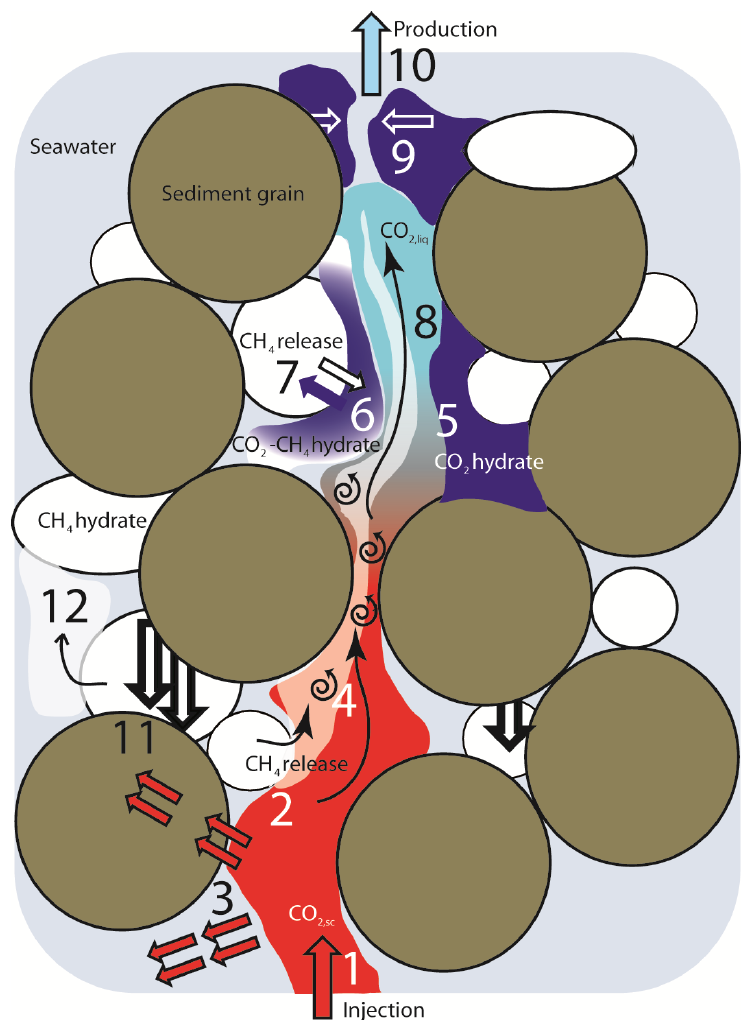
Figure 9. Process dynamics scheme. Relevant transport and reaction processes during injection of hot CO into CH -hydrate bearing sediment. (1) Injection of hot, mobile 2,sc 4 CO ; (2) Fast dissociation of CH -hydrate due to thermal stimulation from hot CO 2,sc 4 2,sc injection; (3) Conductive heat transport via sediment particles or non-mobile pore water followed by thermal stimulation and dissociation of distant CH -hydrate particles; 4 (4) Mixing of CO and CH ; (5) CO -hydrate formation with pore water; (6) Formation of 2 4 2 mixed CO -CH -hydrates from CO -CH gas mixtures; (7) CH -CO -hydrate exchange 2 4 2 4 4 2 limited by diffusive transport of CH and CO ; (8) CO cools and rapidly transforms to 4 2 2,sc CO . CO -CH mixtures remain supercritical at high CH content; (9) CO -hydrate 2,liq 2 4 4 2 formation with excess pore water might result in pore space clogging followed by substantial change of porosity and permeability. Complete loss of hydraulic conductivity is possible; (10) Production of fluid containing CH , water and CO in various states and 4 2 different and changing proportions; (11) Dissociation of load-bearing hydrate particles can cause settling of sediment and change of sediment integrity and geomechanical stability; (12) CH gas might be released into hydraulically isolated pores as non-producible 4